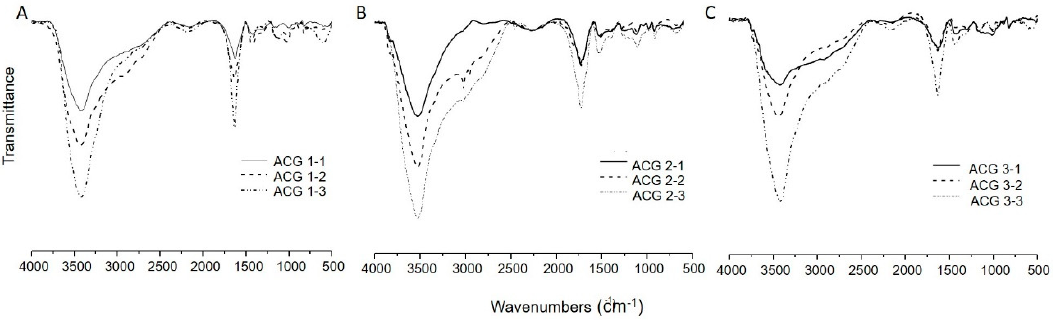
Figure 3. FTIR spectra of ( A ) CAG complex with 0.75% Ca and different concentrations of GSH, ( B ) CAG complex with 1.00% Ca and different concentrations of GSH, ( C ) CAG complex with 1.25% Ca and different concentrations of GSH.